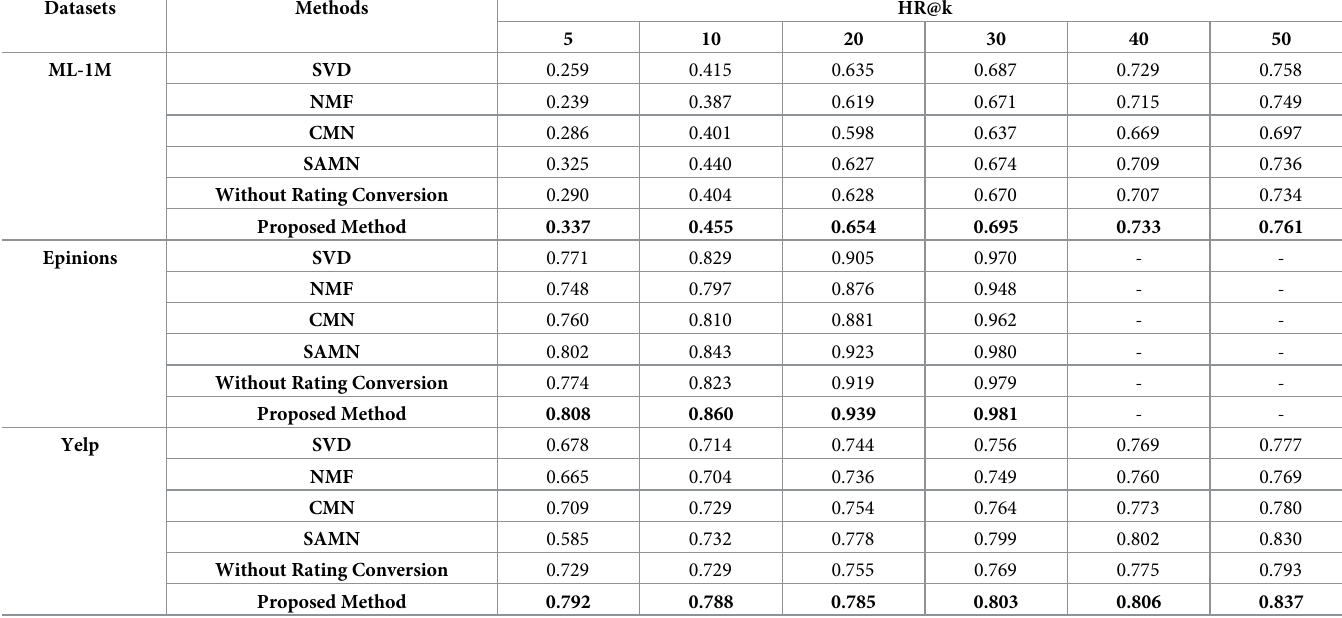
Table 6. Comparison of the experimental results on ML-1M, Epinions, and Yelp datasets using the HR. Datasets